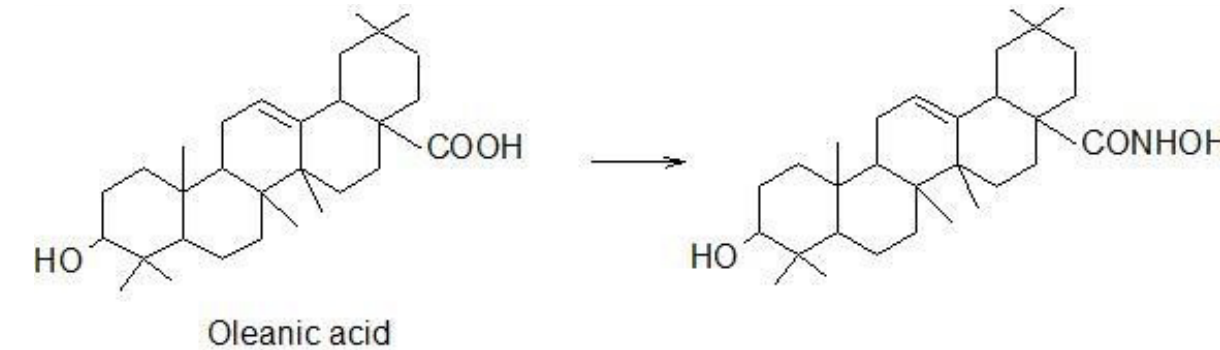
FIGURE7 - R ep lacement of carboxyl group with hydroxamic